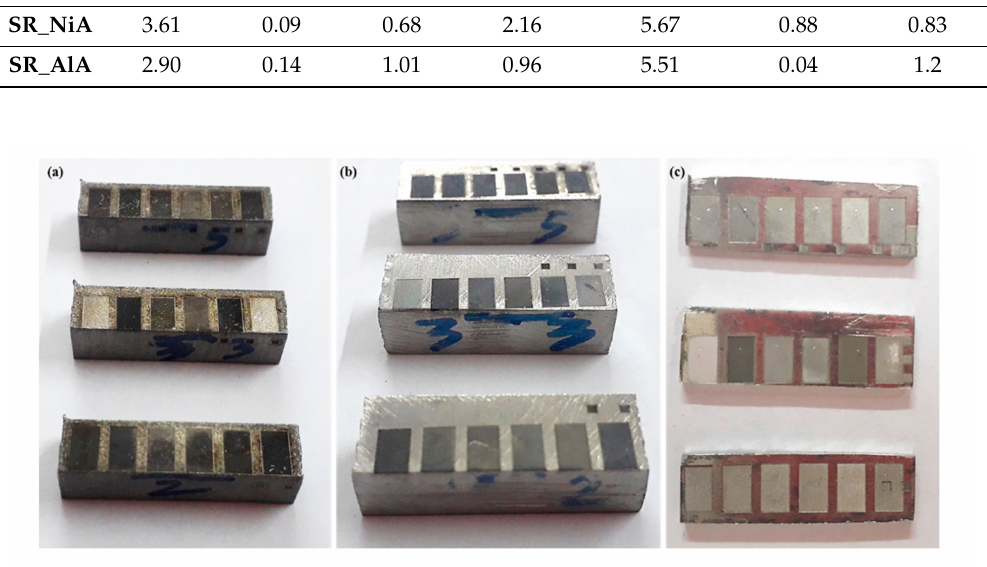
Figure 2. Work specimen after developing micro-depth impressions; ( a ) Inconel 718, ( b ) Ti 6Al 4V, and ( c ) Duralumin.